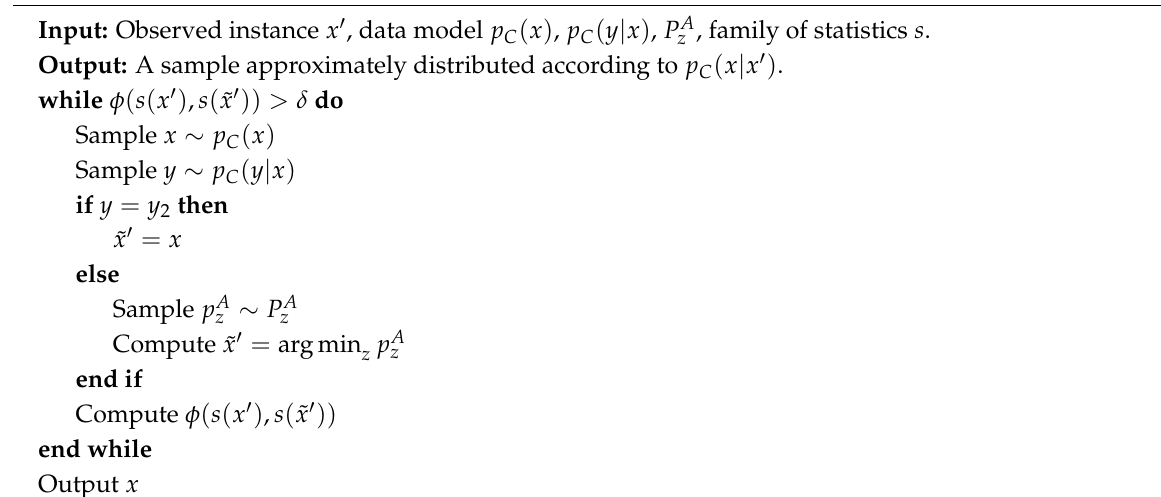
Algorithm 3 ABC scheme to sample from p C ( x